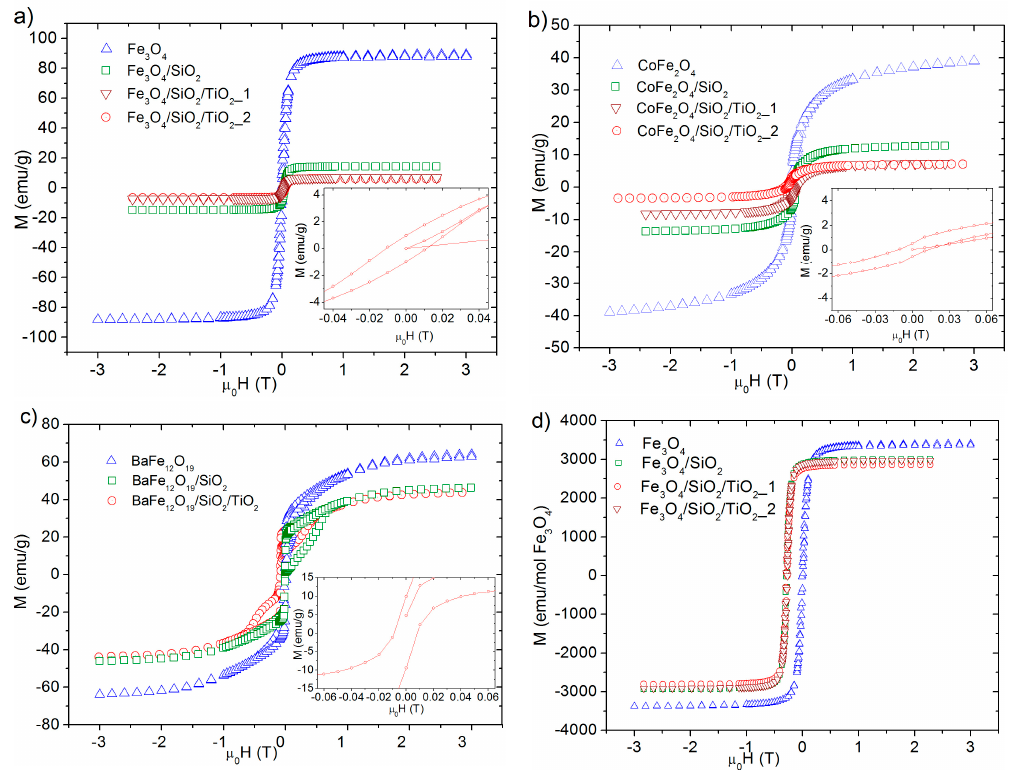
Figure 7. Magnetic hysteresis loops of Fe 3 O 4 based nanocomposites ( a ); CoFe 2 O 4 ‐ based nanocomposites ( b ) and BaFe 12 O 19 ‐ based nanoparticles ( c ); recalculated hysteresis loops for Fe 3 O 4 composites ( d ). The magnetic photocatalysts can exhibit superparamagnetic behavior due to their small H c and M r